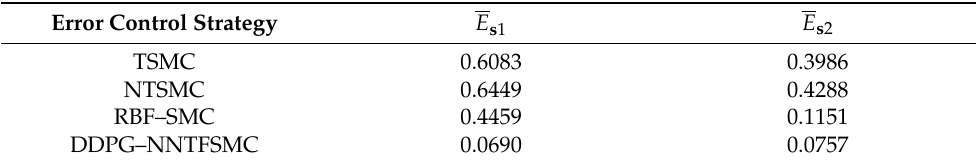
Table 4. The control parameter selection for the control strategies.